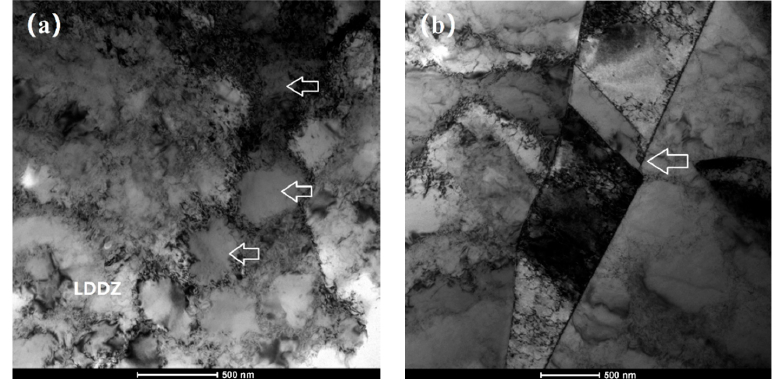
Figure 4. Transmission electron microscopy (TEM) images of the Cu-Mg alloy after SNC: ( a ) at lower magnification of the dislocation tangle; ( b ) at higher magnification of the twin zone.